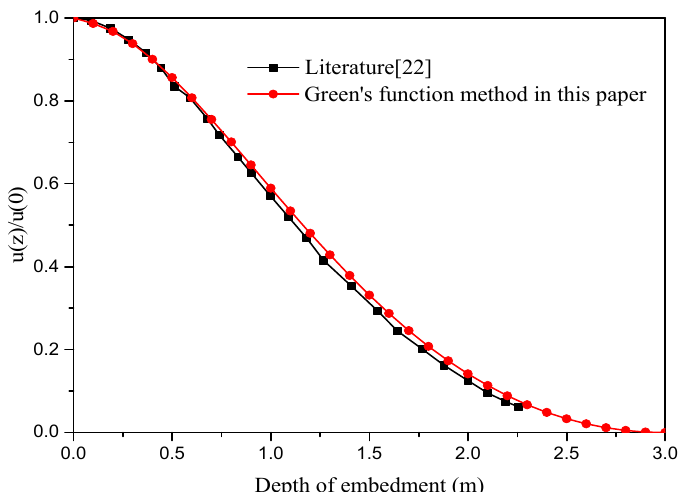
Figure 5. Comparison of pile displacement calculated by Green’s functions method and the litera- ture [22,25].